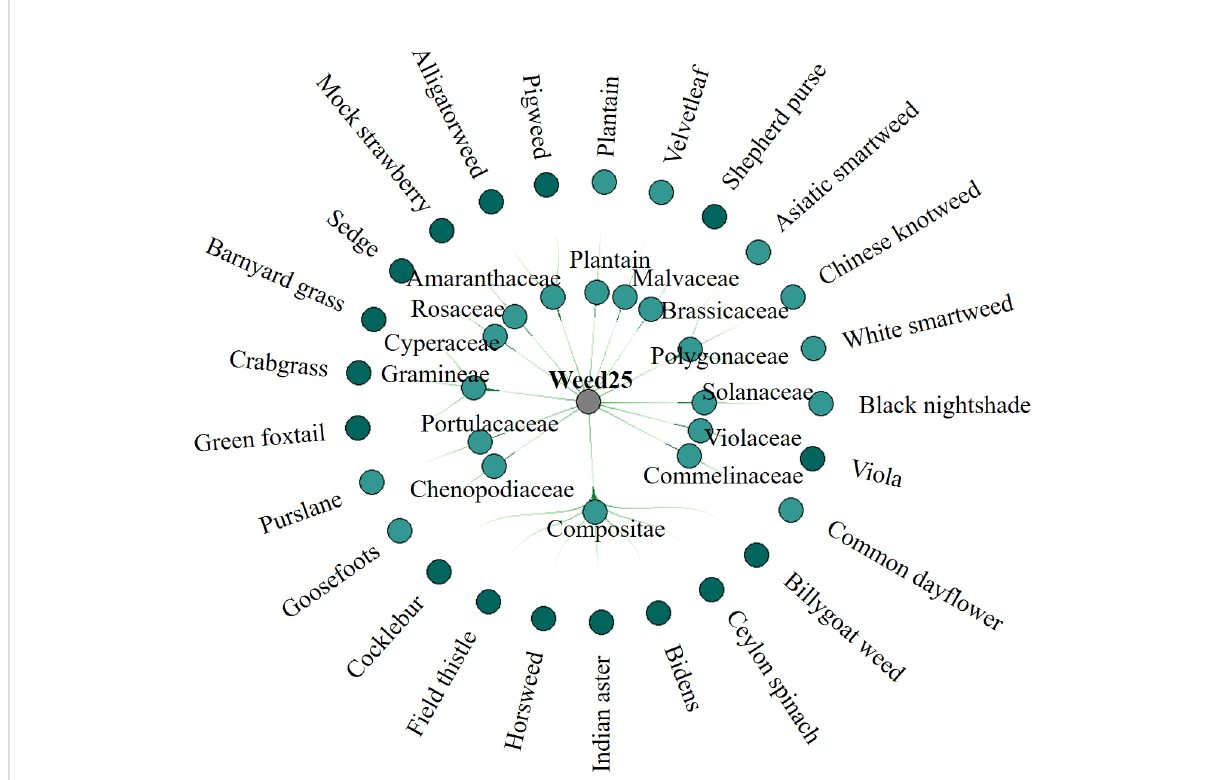
FIGURE 4 Classi fi cation structure hierarchy of Weed25 dataset. The dataset includes 25 weed species from 14 families.